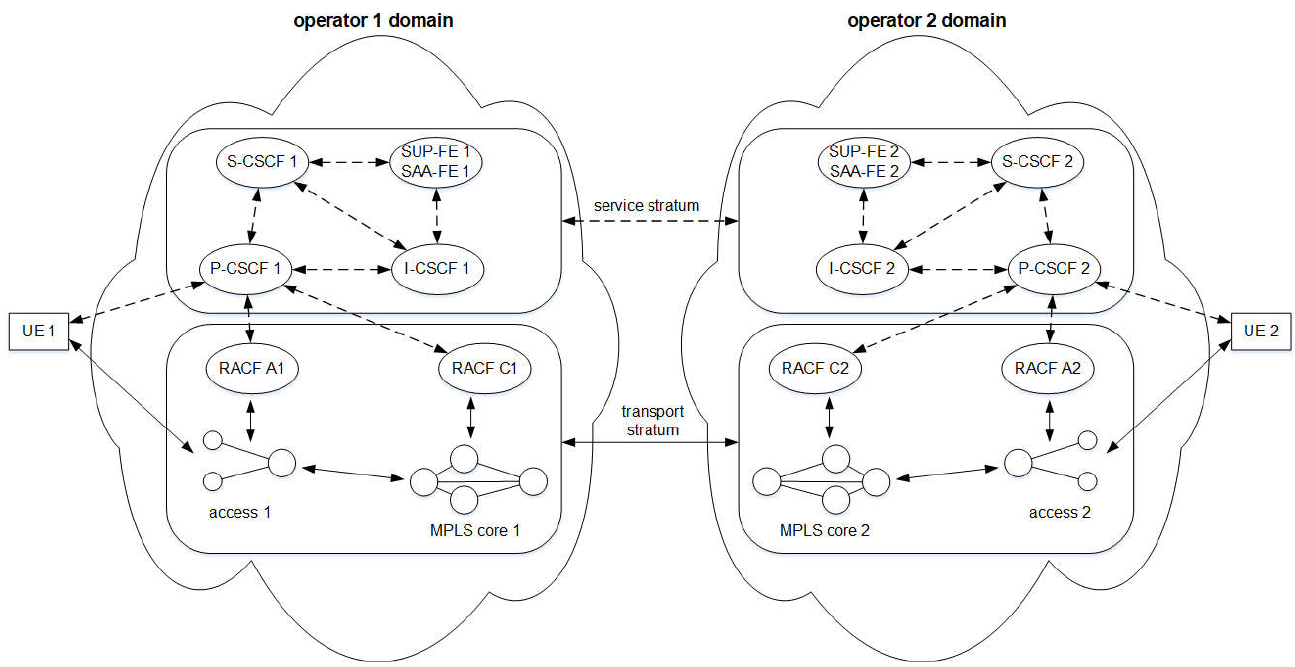
Figure 1. Structure of the multidomain IMS/NGN network with an MPLS-based transport stratum.